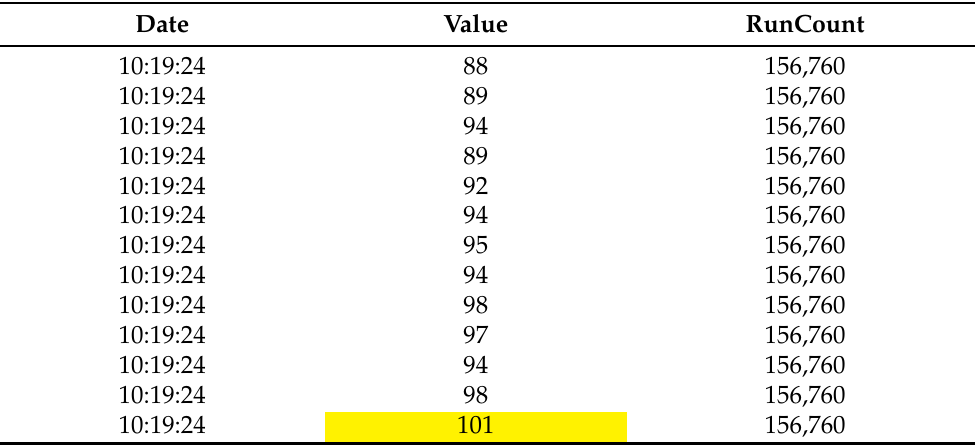
Table 1. Raw Data Extracted from the Machine with OPC-UA (Maximum Injection